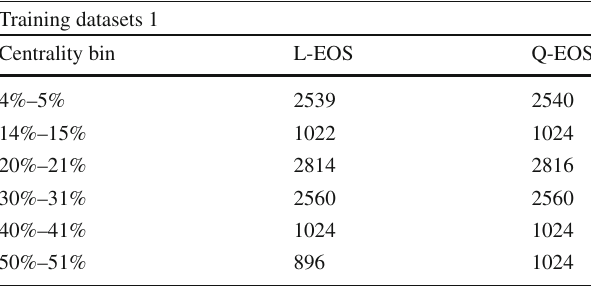
Table 1 Training datasets 1: numbers of event-by-event spectra ρ( p ,(cid:6)) computed by the iEBE-VISHNU hybrid model with the MC- T Glauber initial conditions in the centrality range 0–60%. The ratio of shear viscosity to entropy density η/ s = 0 . 08. The equilibration time τ = 0 . 5 fm / c. The switching temperature T = 137 MeV. The colli- √ s w 0 s NN = 2 . 76 TeV sion system is Pb + Pb at